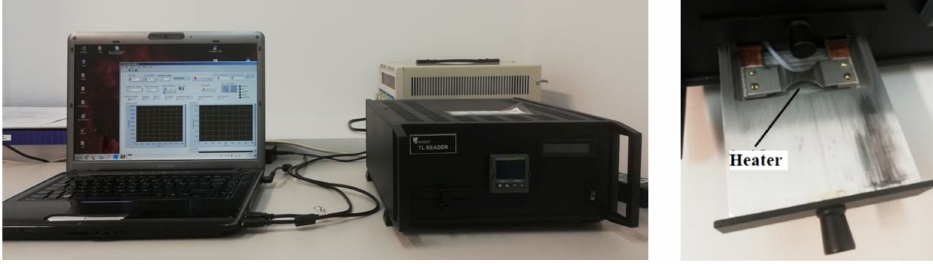
Figure 2. TSL reader at Chair for Optoelectronic Materials of the Institute of Physics Kazimierz Wielki University in Bydgoszcz.